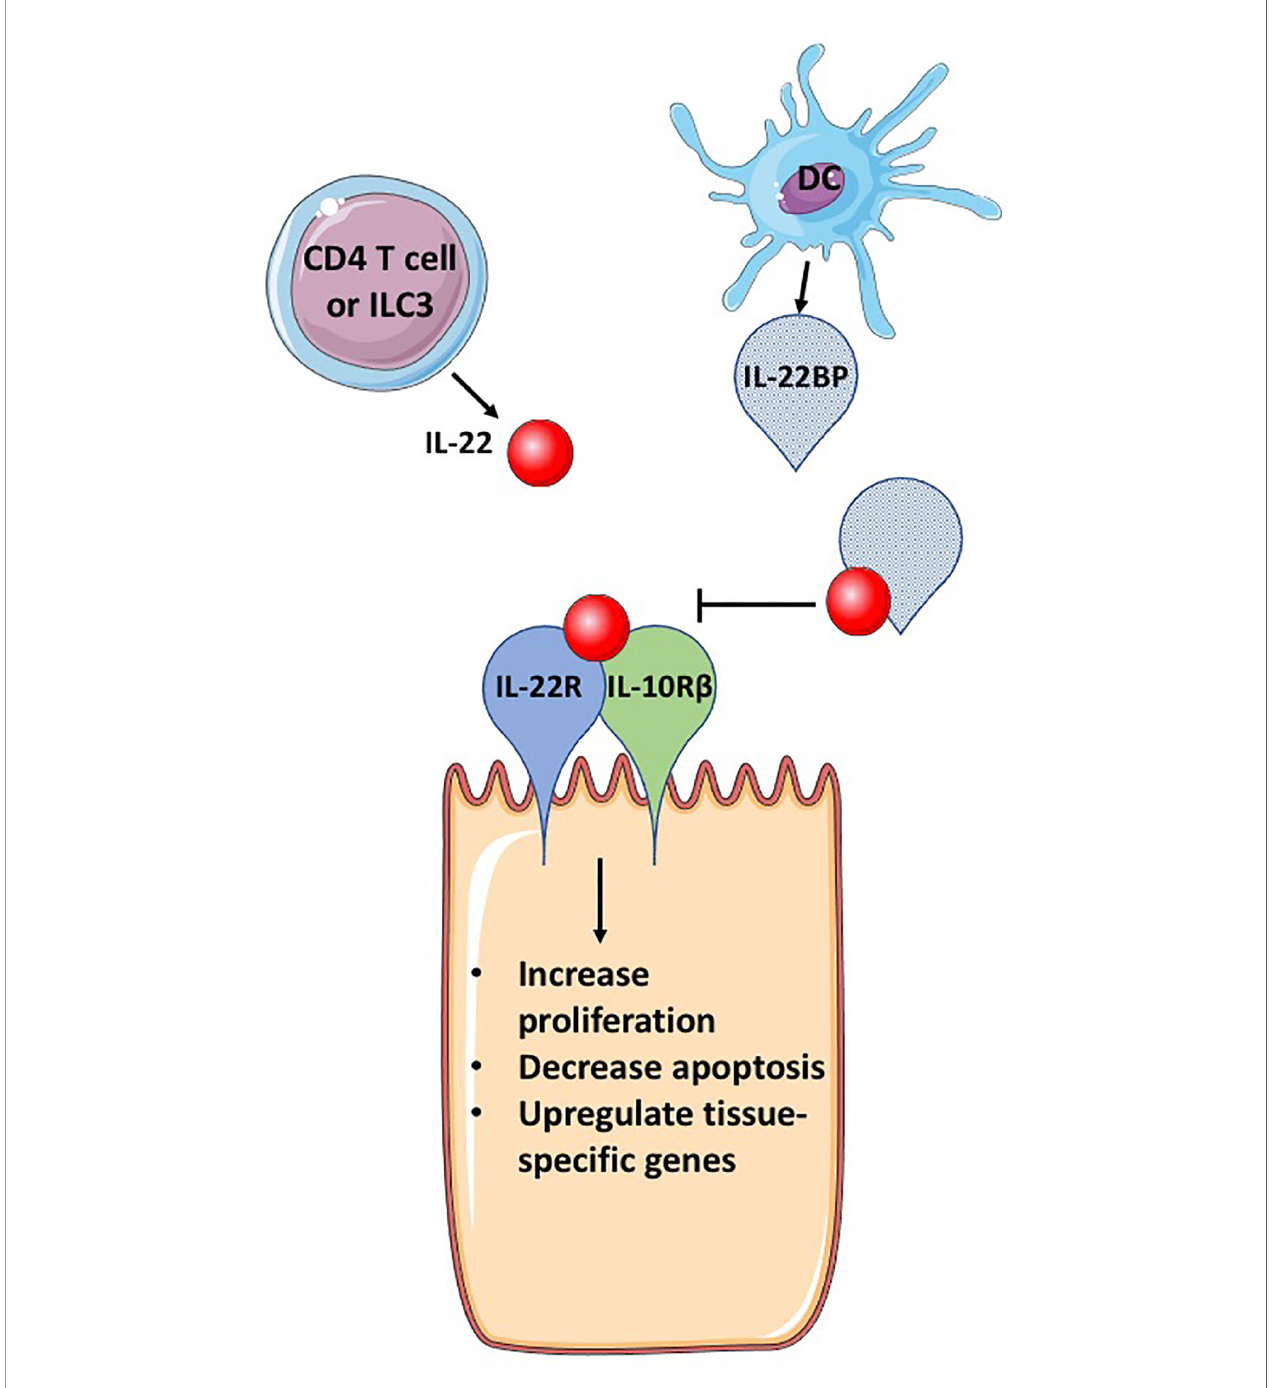
FIGURE 1 | IL-22BP blocks IL-22 signaling. IL-22 is secreted primarily by CD4 T cells and group 3 innate lymphocytes (ILC3s). The receptor for IL-22, a heterodimeric complex of IL-22R and IL-10R b , binds IL-22, activating signaling pathways that induce genes important for cellular proliferation, inhibition of apoptosis and tissue speci fi c genes, that can include antimicrobial proteins and mucins. IL-22BP is produced primarily by DCs, is a homolog of IL-22R but lacks a transmembrane domain, allowing for secretion of IL-22BP. IL-22BP binds IL-22 with up to 10,000 greater af fi nity than IL-22R and therefore in the presence of IL-22BP, most IL-22 binds IL-22BP, inhibiting its ability to bind to the IL-22 receptor complex and cause changes in epithelial cells. This fi gure is based on our knowledge of IL-22 biology using mouse models. The fi gure was prepared by modifying Servier Medical Art, licensed under a Common Attribution 3.0 Generic License.